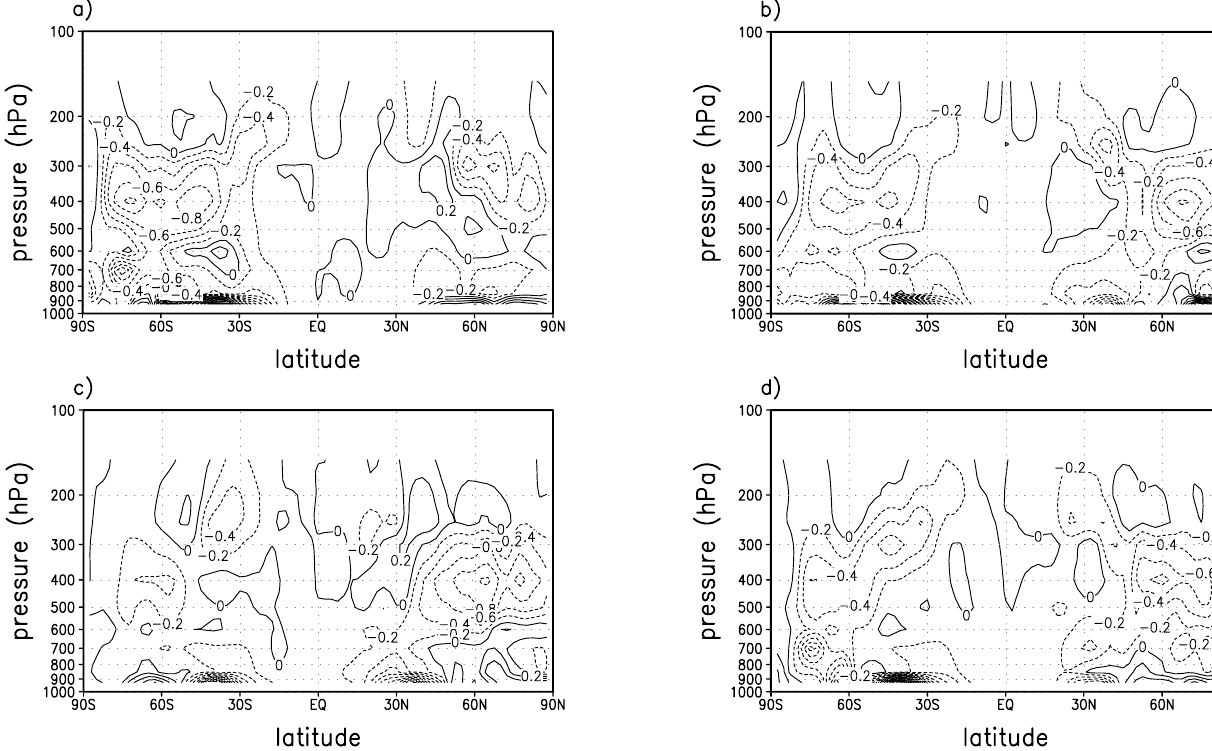
Fig. 1. Zonally-averaged PV transport for: (a) July 1997, (b) October 1997, (c) January 1998 and (d) April 1998. Units, 10 − 4 ms − 2 .